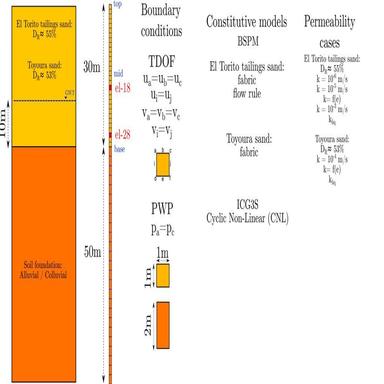
Site response column soil profiles, finite element mesh and modelling aspects.